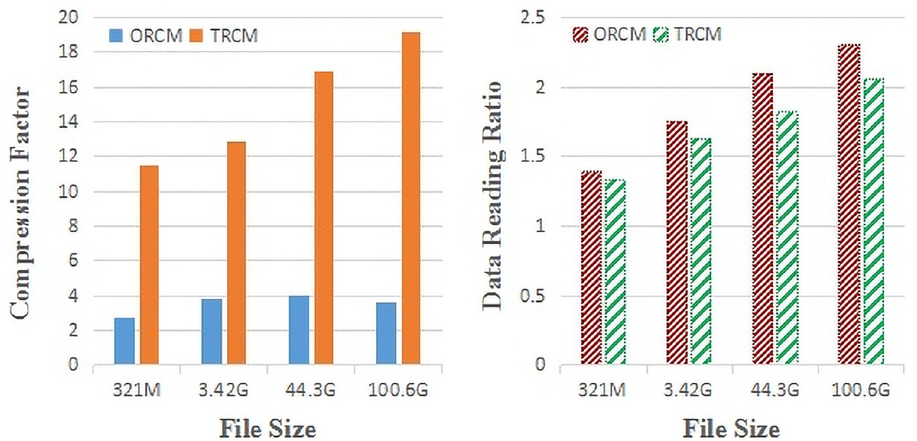
Fig 6. Reading capabilities of TRCMGene. Reading time ratio was defined as the ratio between the time of reading uncompressed file and the time of reading compressed file (greater is better).